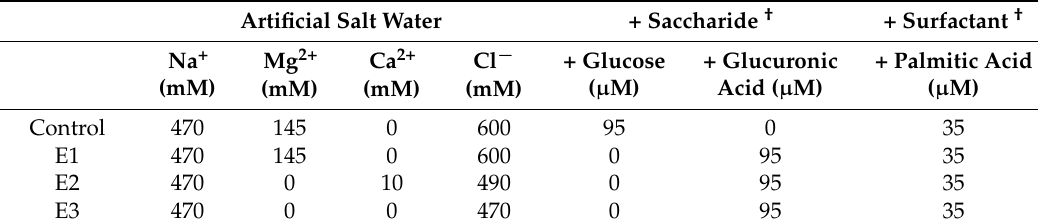
Table 1. Water-side concentrations of individual compounds in the Marine Aerosol Reference Tank (MART). Each experiment (control, experiment 1 (E1), experiment 2 (E2), experiment 3 (E3)) was initiated with a synthetic sea salt mixture, followed by sequential additions of soluble (+ saccharide) and insoluble (+ surfactant) organic